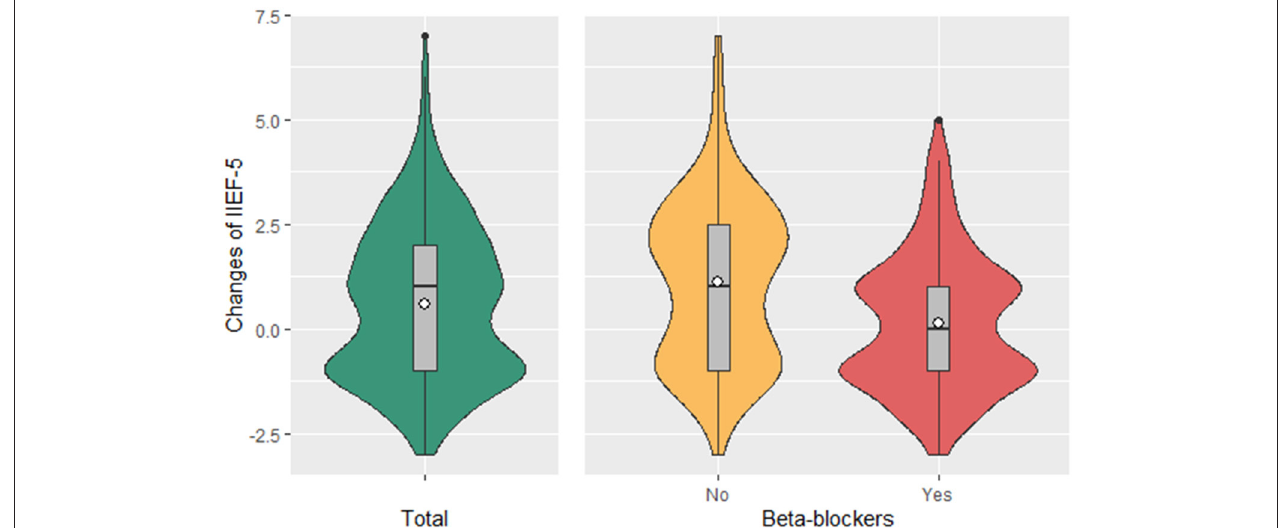
FIGURE 2 | Changes in IIEF-5 Score in patients with or without beta blocker use. Mean change in IIEF-5 in patients on beta blockers (157, 53.0%) was 0.12, P = 0.09; mean change in IIEF-5 in patients not on beta blockers (139, 47.0%) was 1.11, P < 0.001. P -values were estimated from the linear mixed-effects models after adjustment for BMI, smoking, alcohol use, UA, CRP, HbA1c, Apo-A, Apo-E, the TG and HDL-C ratio, and the history of diabetes mellitus and atrial fibrillation. ANOVA P < 0.001 for the comparison between patients with or without beta blocker use, adjusted for BMI, smoking, alcohol use, UA, CRP, HbA1c, Apo-A, Apo-E, the TG and HDL-C ratio, and the history of diabetes mellitus and atrial